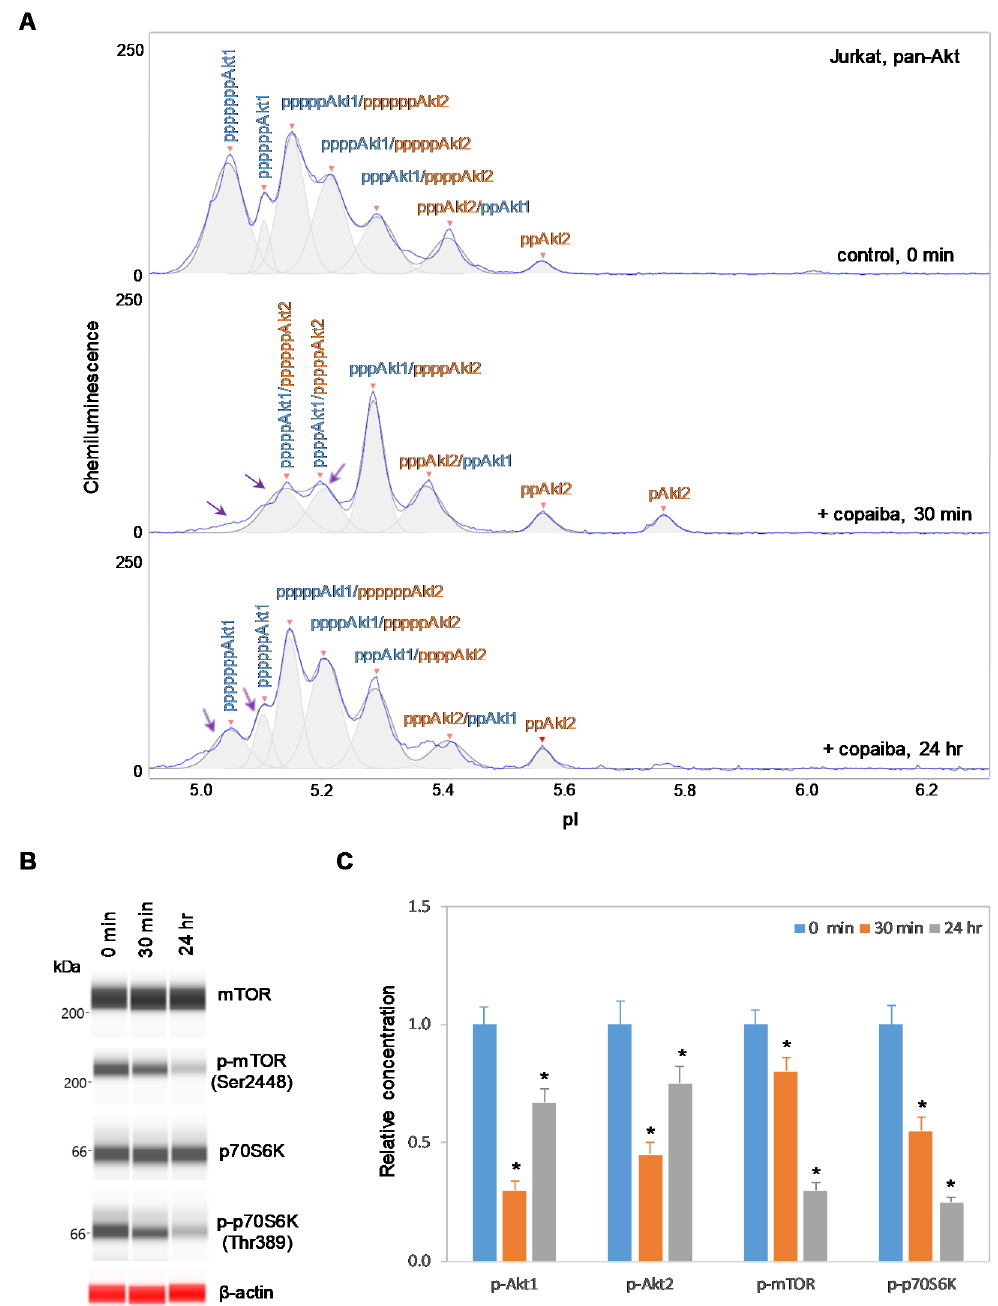
Figure 5. Negative regulation of the pI3K/Akt/mTOR signaling pathway in Jurkat T-cells by copaiba essential oil. ( A ) cIEF electropherograms of pan-Akt in Jurkat cells before (0 min) and after (30 min and 24 h) treatment with copaiba essential oil. Peaks associated with Akt isoforms are labeled and color-coded: Akt1 (blue) and Akt2 (orange). The purple arrows point to highly phosphorylated Akt1 peaks that exhibited a reduced amplitude following treatment with copaiba essential oil. ( B ) Expression levels of the mTOR and p70S6K phosphoisoforms as a function of time after treatment with copaiba essential oil. β-Actin serves as the loading control. ( C ) Relative concentrations of Akt1, Akt2, Akt3, mTOR, and p70S6K phosphoisoforms as a function of time after treatment with copaiba essential oil. The relative concentration describes the fold change in the expression level of a protein phosphoisoform after treatment compared to that under the control condition. The error bars indicate the standard deviations of six repeated measurements per experimental condition. The asterisks indicate a statistical significance of p ≤ 0.05 versus the control. Jurkat cells were treated with 100 ng/mL copaiba essential oil.